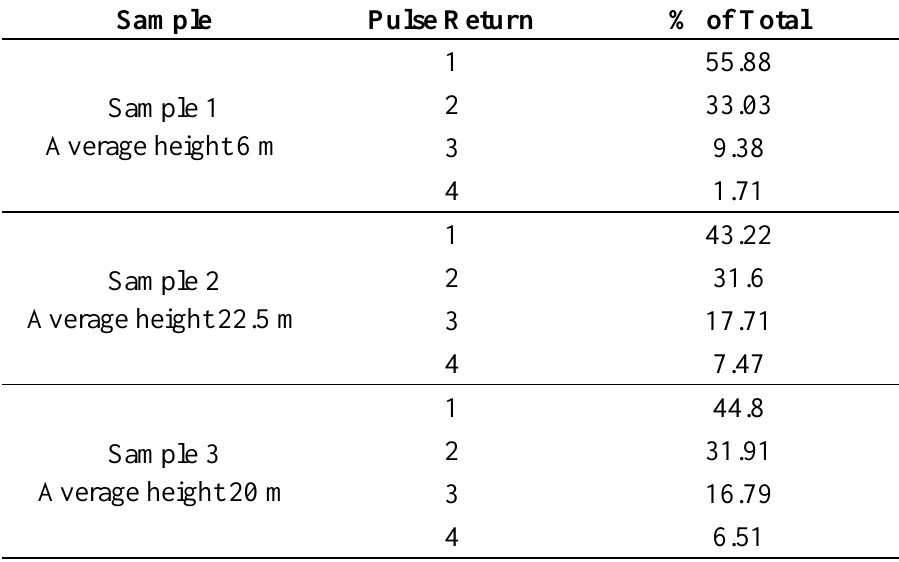
Table 3. ALTM-Orion: Distribution of multiple returns for the mixed forest